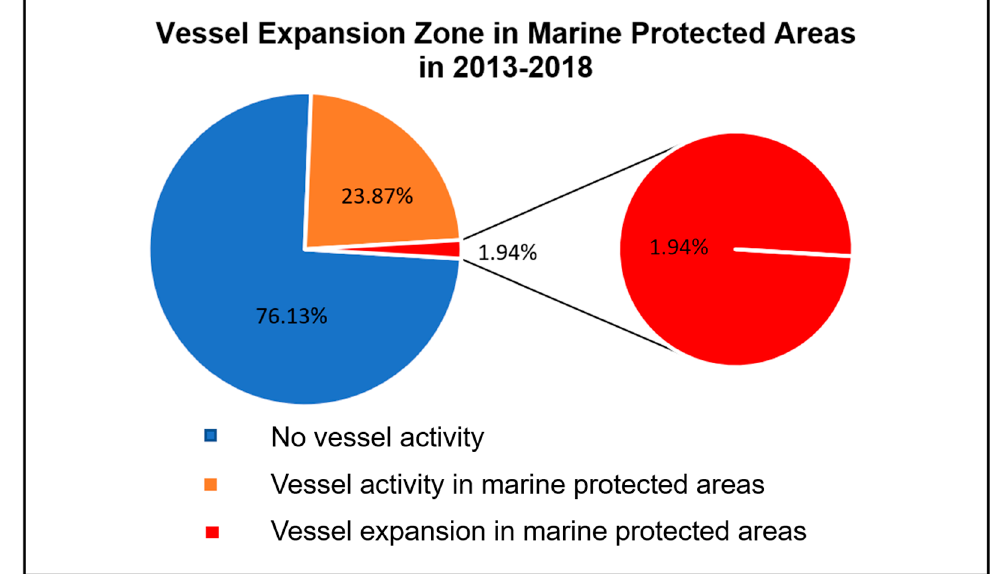
Figure 7. Pie chart illustrating the vessel expansion zone in the MPAs of Indonesia.